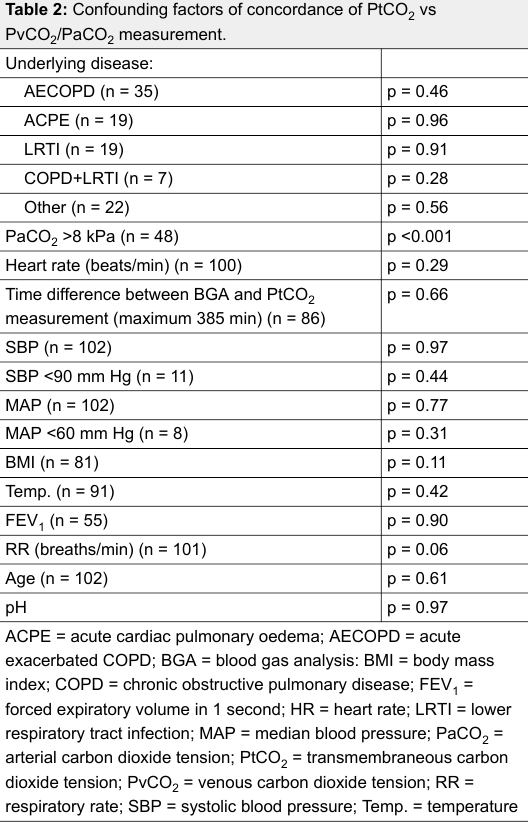
Table 2: Confounding factors of concordance of PtCO 2 vs PvCO 2 /PaCO 2 measurement.